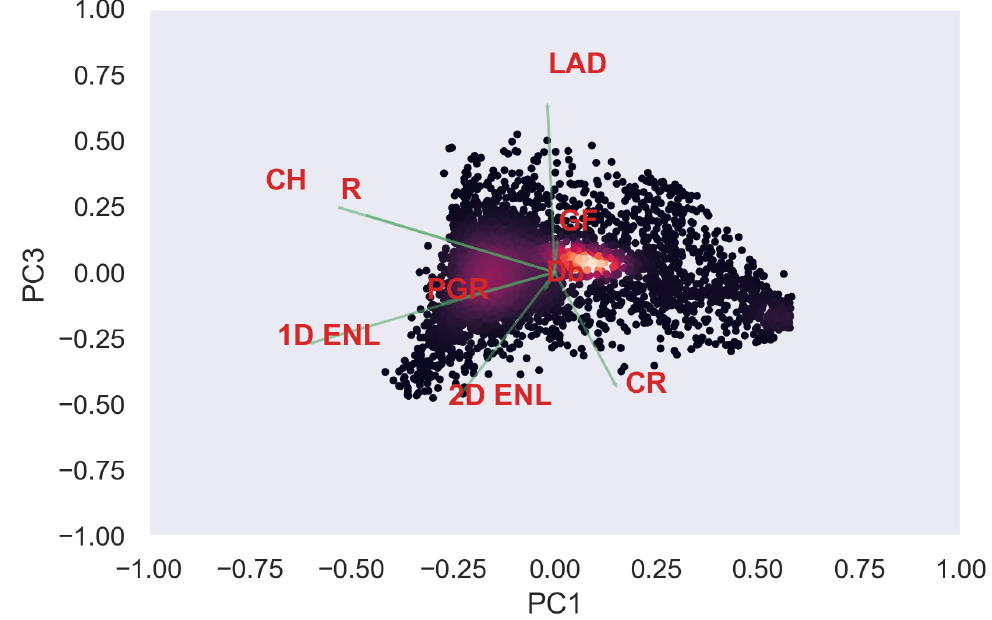
Figure A36. TLS PCA band 1 and 3 loadings at 1m grid